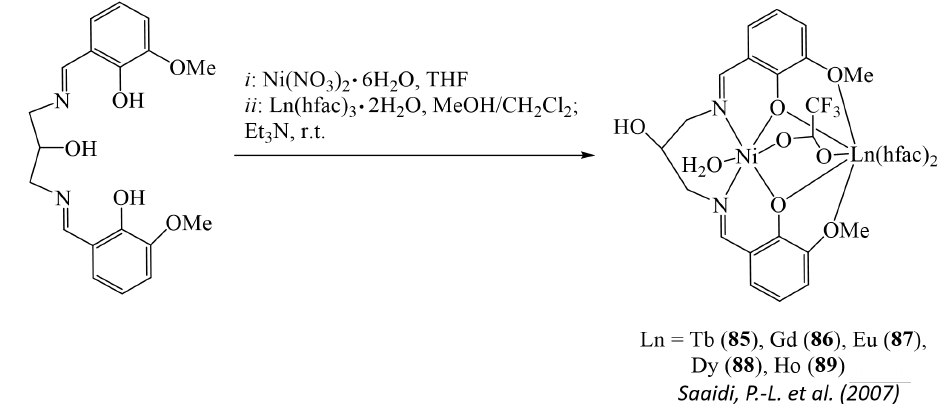
Scheme 31. Synthesis of heterometallic [Ln-Ni] complexes 85 – 89 [129].